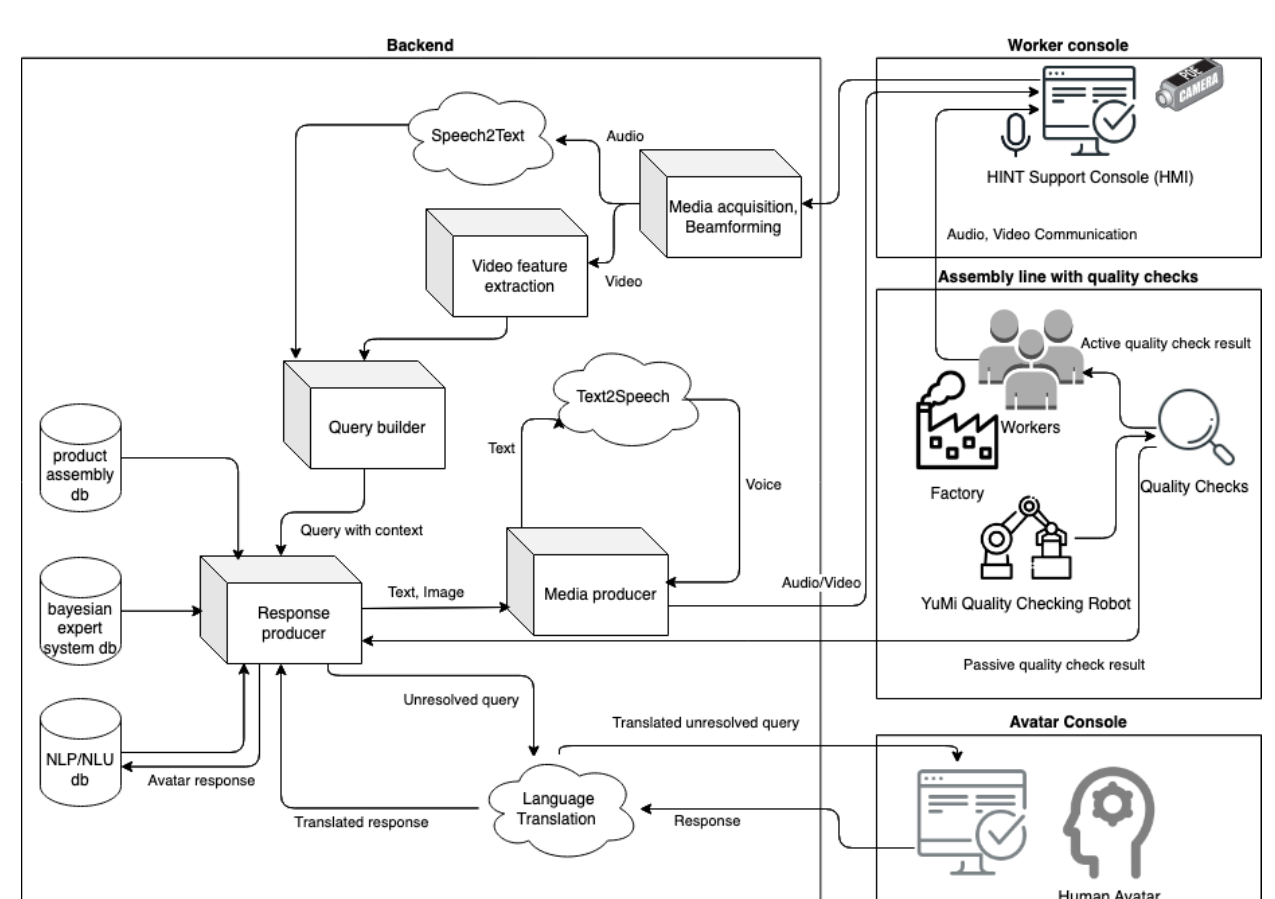
Figure 1. Main components diagram of the Hybrid Intelligence System